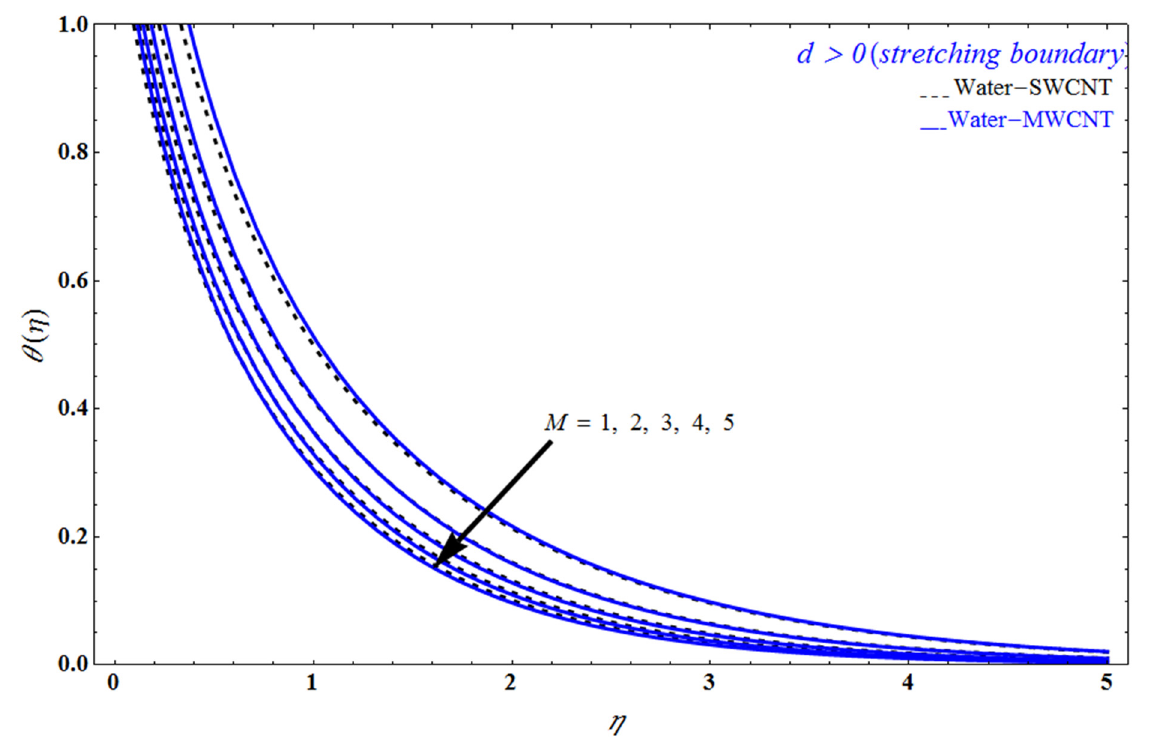
( ) θ η ( ) θ η versus similarity variable versus similarity variable